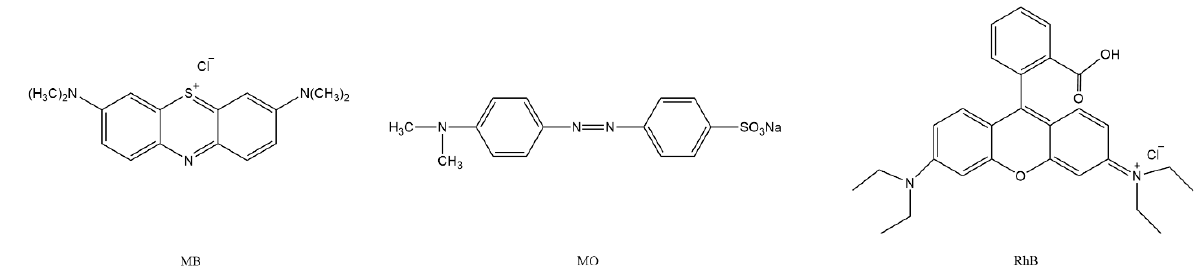
Figure 5. Structural formula of MB, MO, and RhB.